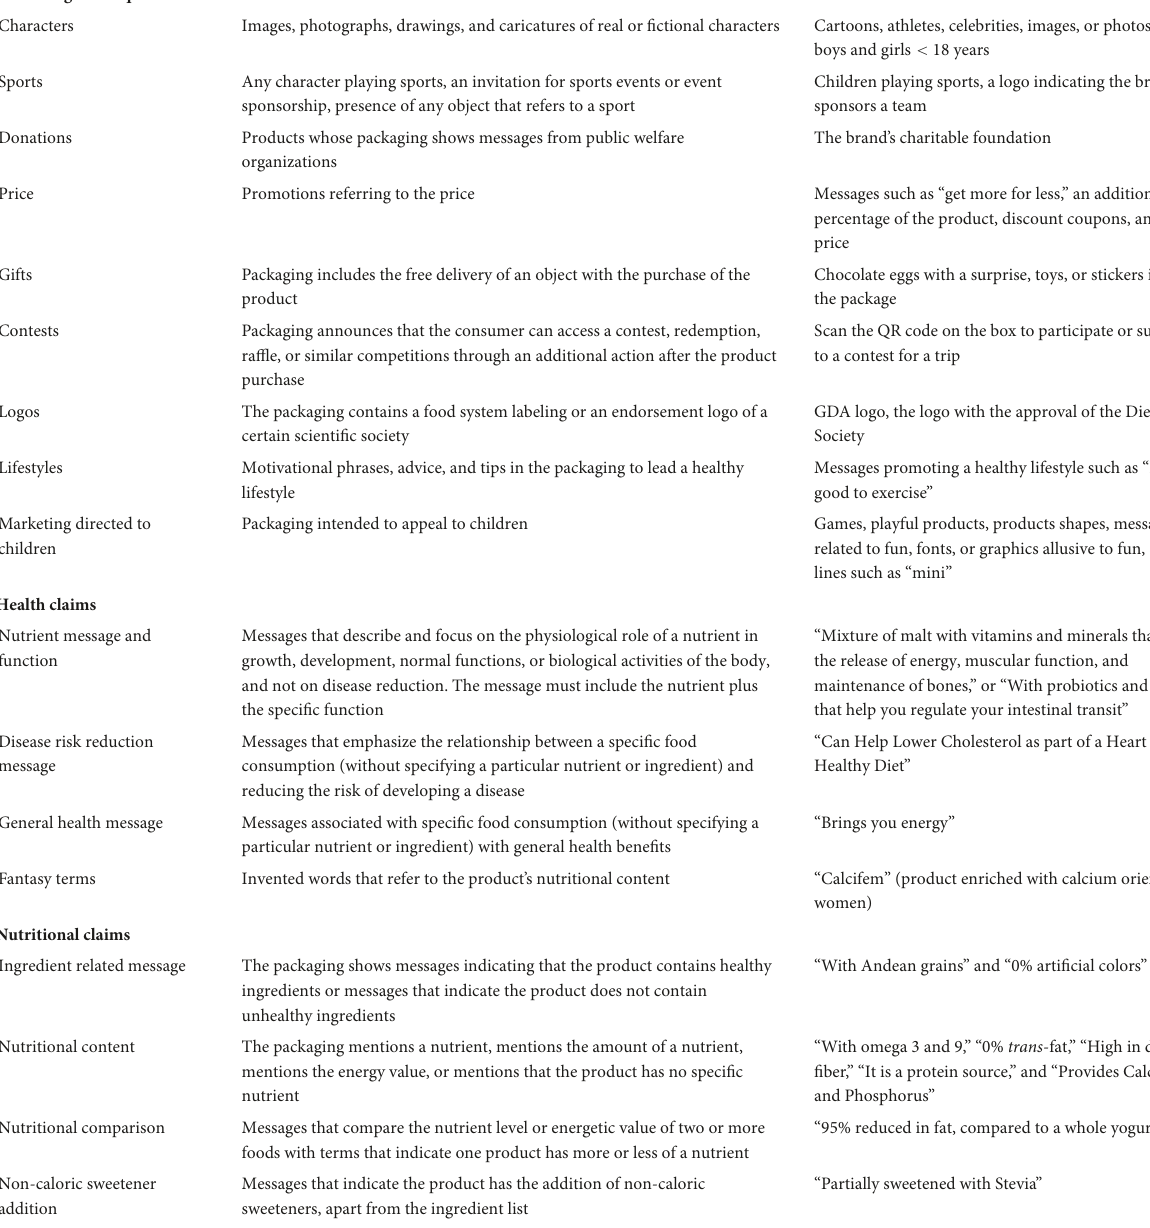
TABLE 1 Variables: Marketing strategies